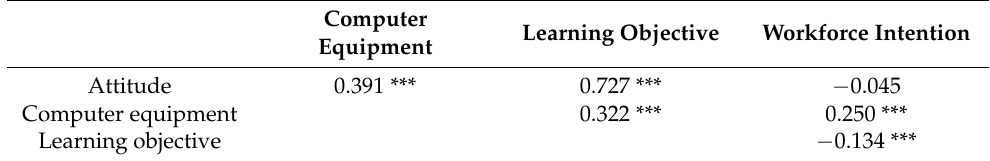
Table 6. Correlation analysis of each scale (n =